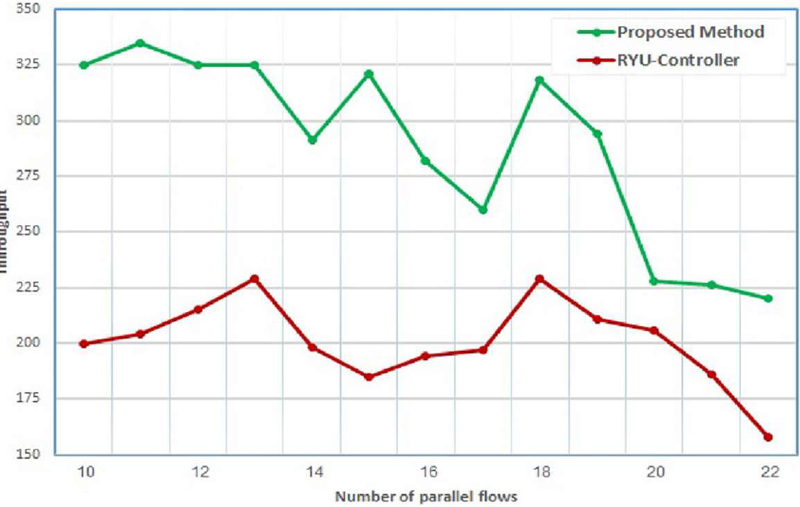
Figure 9. Comparison Between the Proposed Method and the Ryu Controller With Respect to Throughput for the Two Types of Flows.